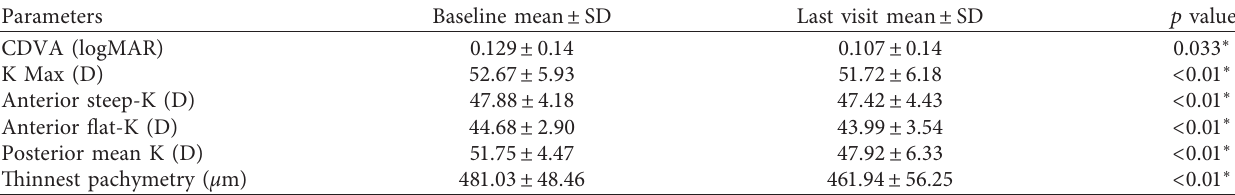
Table 2: The changes in mean different topographic parameters between baseline and the last follow-up after crosslinking and their p value. Parameters